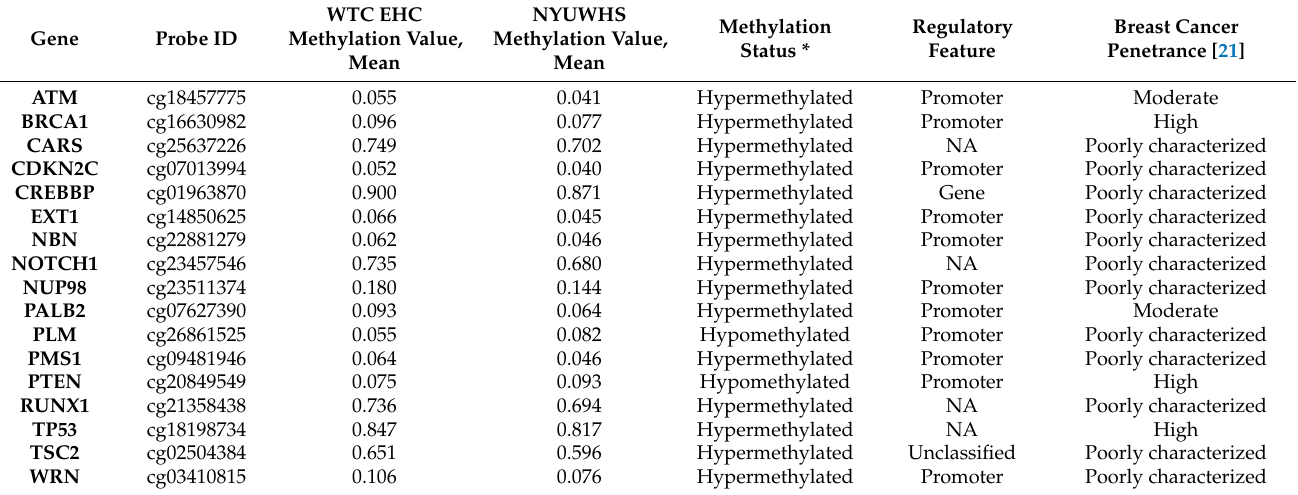
Table 3. Methylation status of differentially expressed known tumor suppressor genes in the (WTC EHC) breast cancer vs. unexposed (NYUWHS) pre-diagnostic breast cancer